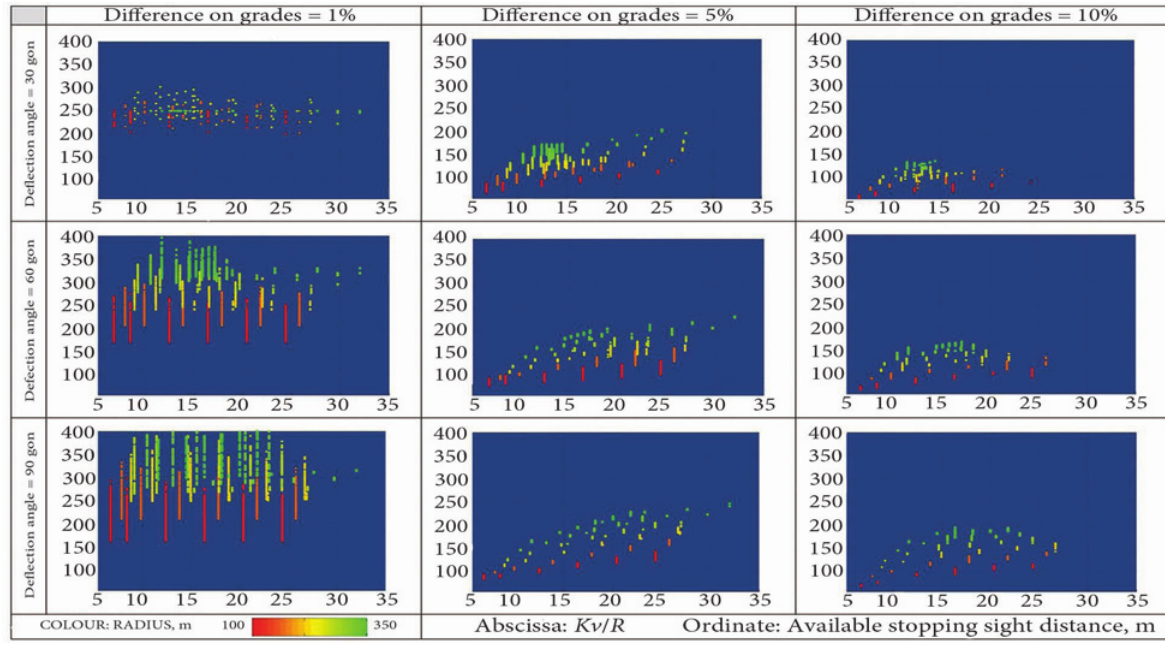
Fig. 7. Effect of on available sight distance depending on radius, deflection angle and algebraic difference on